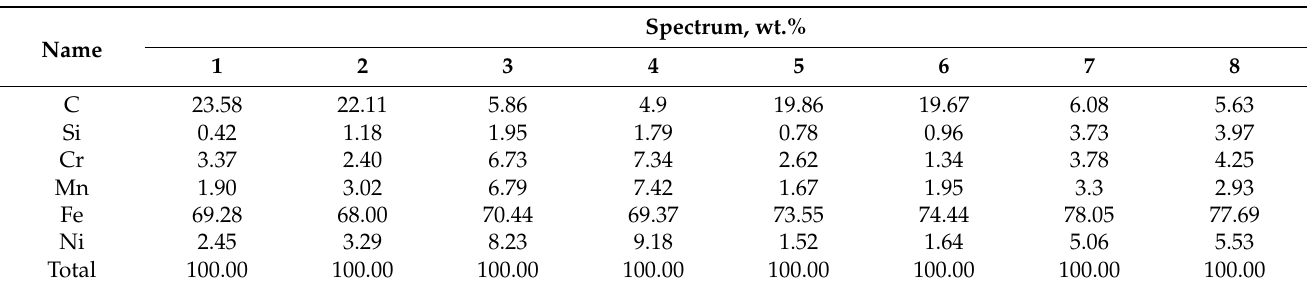
Table 2. The results of EDS point analyses of the coating components.